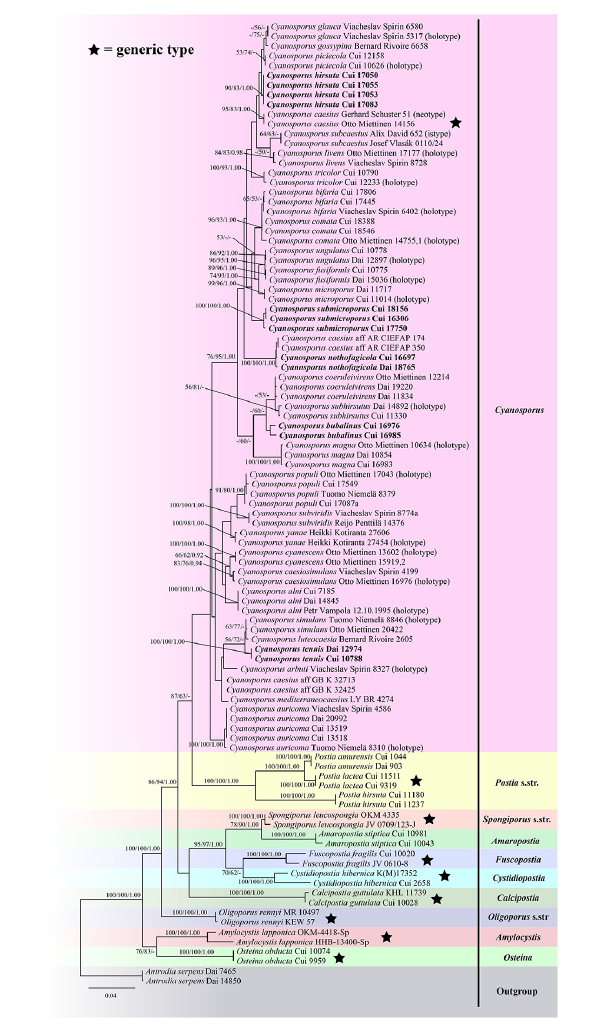
FIGURE 1 | Maximum likelihood tree illustrating the phylogeny of Cyanosporus and its related genera in the antrodia clade based on sequences dataset of ITS + TEF. Branches are labeled with maximum likelihood bootstrap higher than 50%, parsimony bootstrap proportions higher than 50% and Bayesian posterior probabilities more than 0.90 respectively. Bold names = New species.